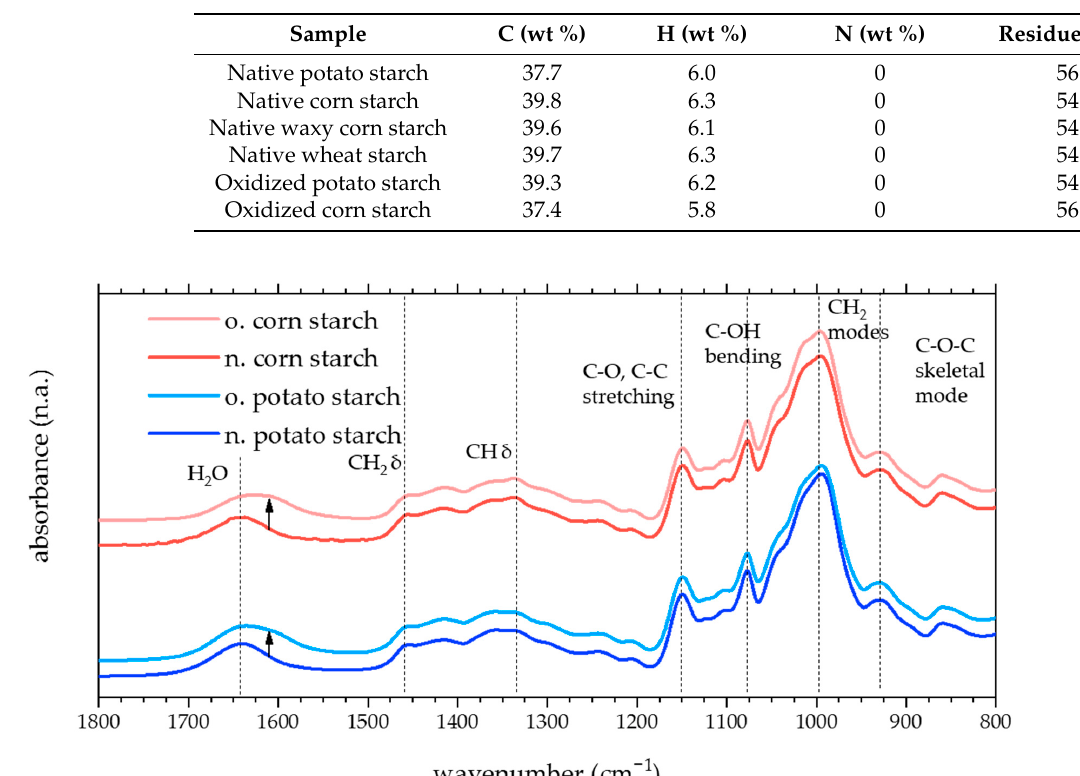
Figure 1. ( a ) Streaming potential vs. pH curves and ( b ) charge densities at pH values of 3 (solid), 5 (striped), and 9 (crossed) of native potato starch (blue), native corn starch (red), native waxy corn starch (orange), native wheat starch (green), oxidized potato starch (light blue), and oxidized corn starch (pink). Table 1. Results of the elemental analysis for the different starches. Residue here describes the relative mass that was not attributed to the elements C, H, and N.